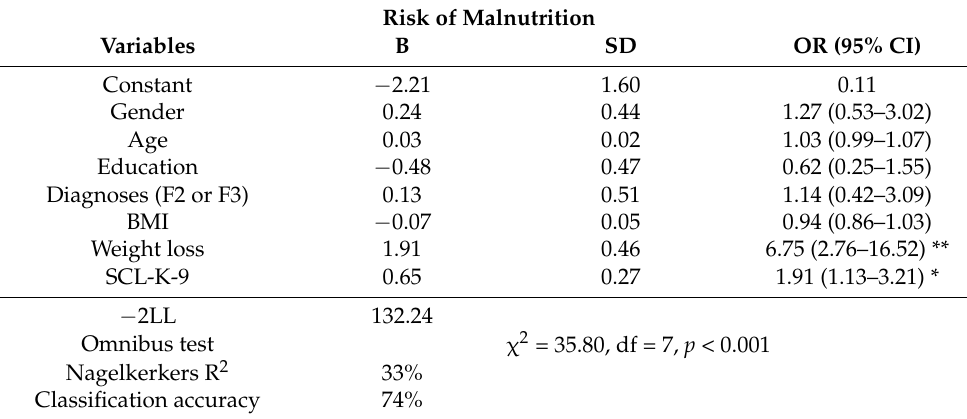
Table 3. Predictors of the risk of